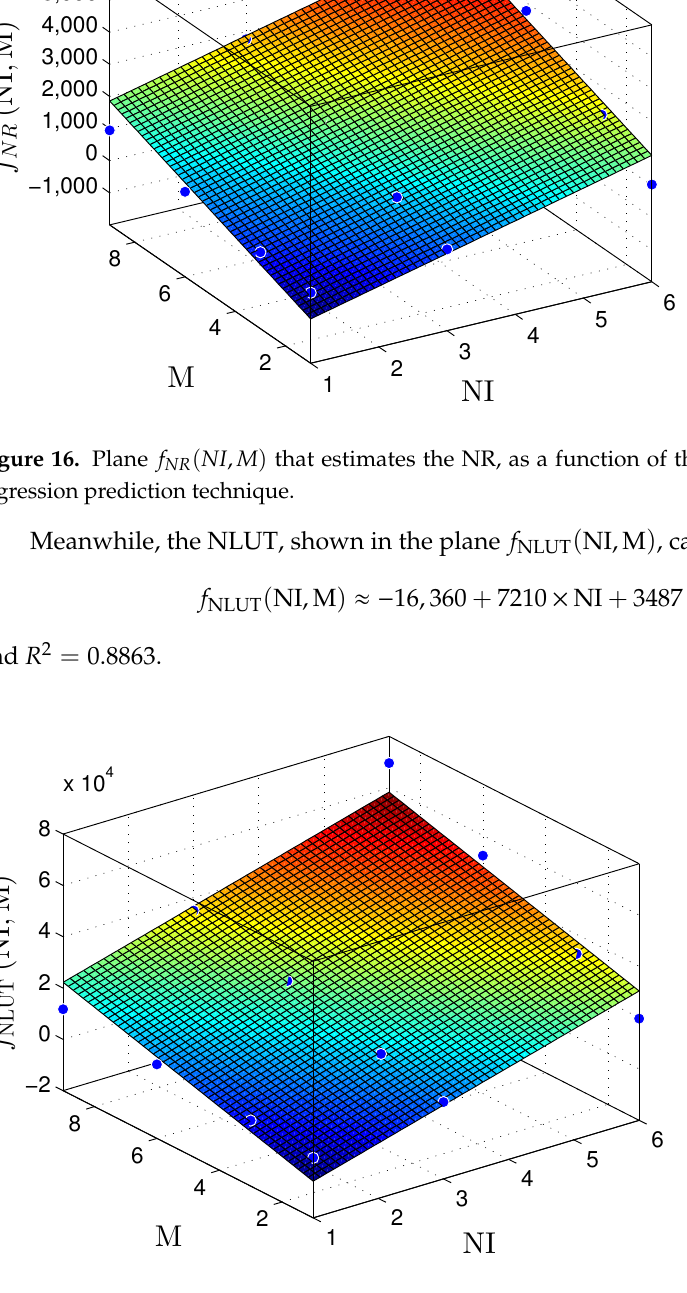
Figure 17. Plane f NLUT ( NI , M ) that estimates the NLUTs, as a function of the NI and M, for the linear regression prediction